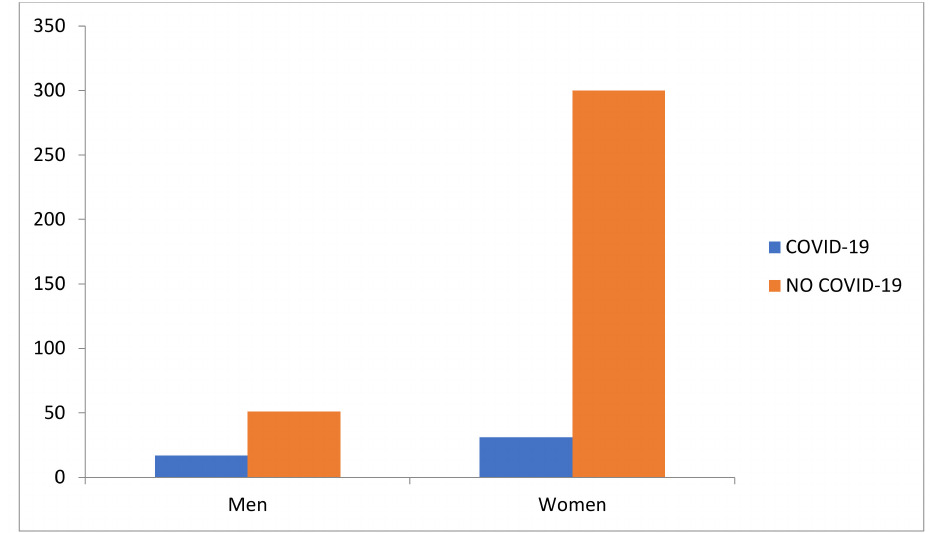
Figure 1. Frequencies of having suffered from COVID-19 based on sex.